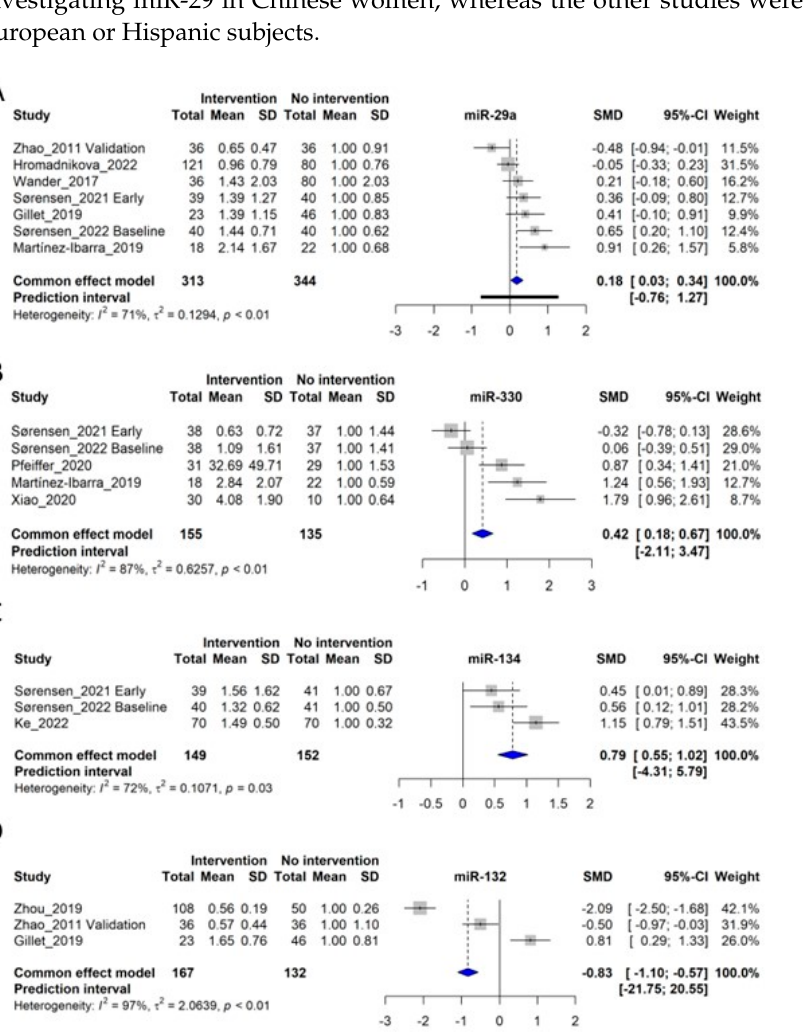
Figure 4. Forest plots of the fi xed-e ff ect meta-analysis of ( A ) miR-29a [9,18,20,21,28,33,41], ( B )